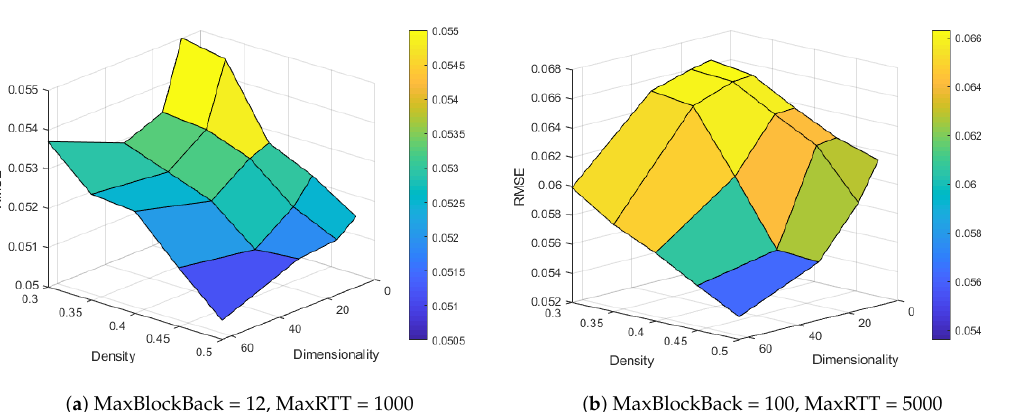
Figure 6. Performance of Different Dimensionality and Matrix